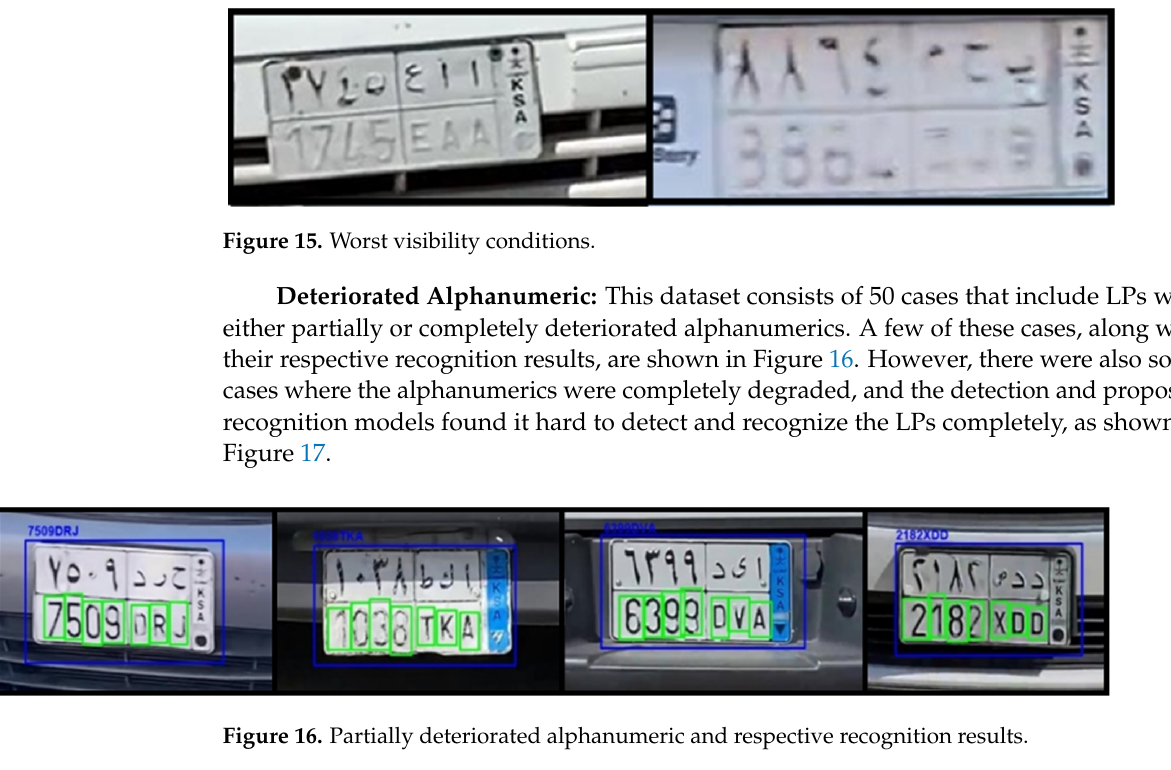
Figure 14. Recognition results under extreme visibility conditions.